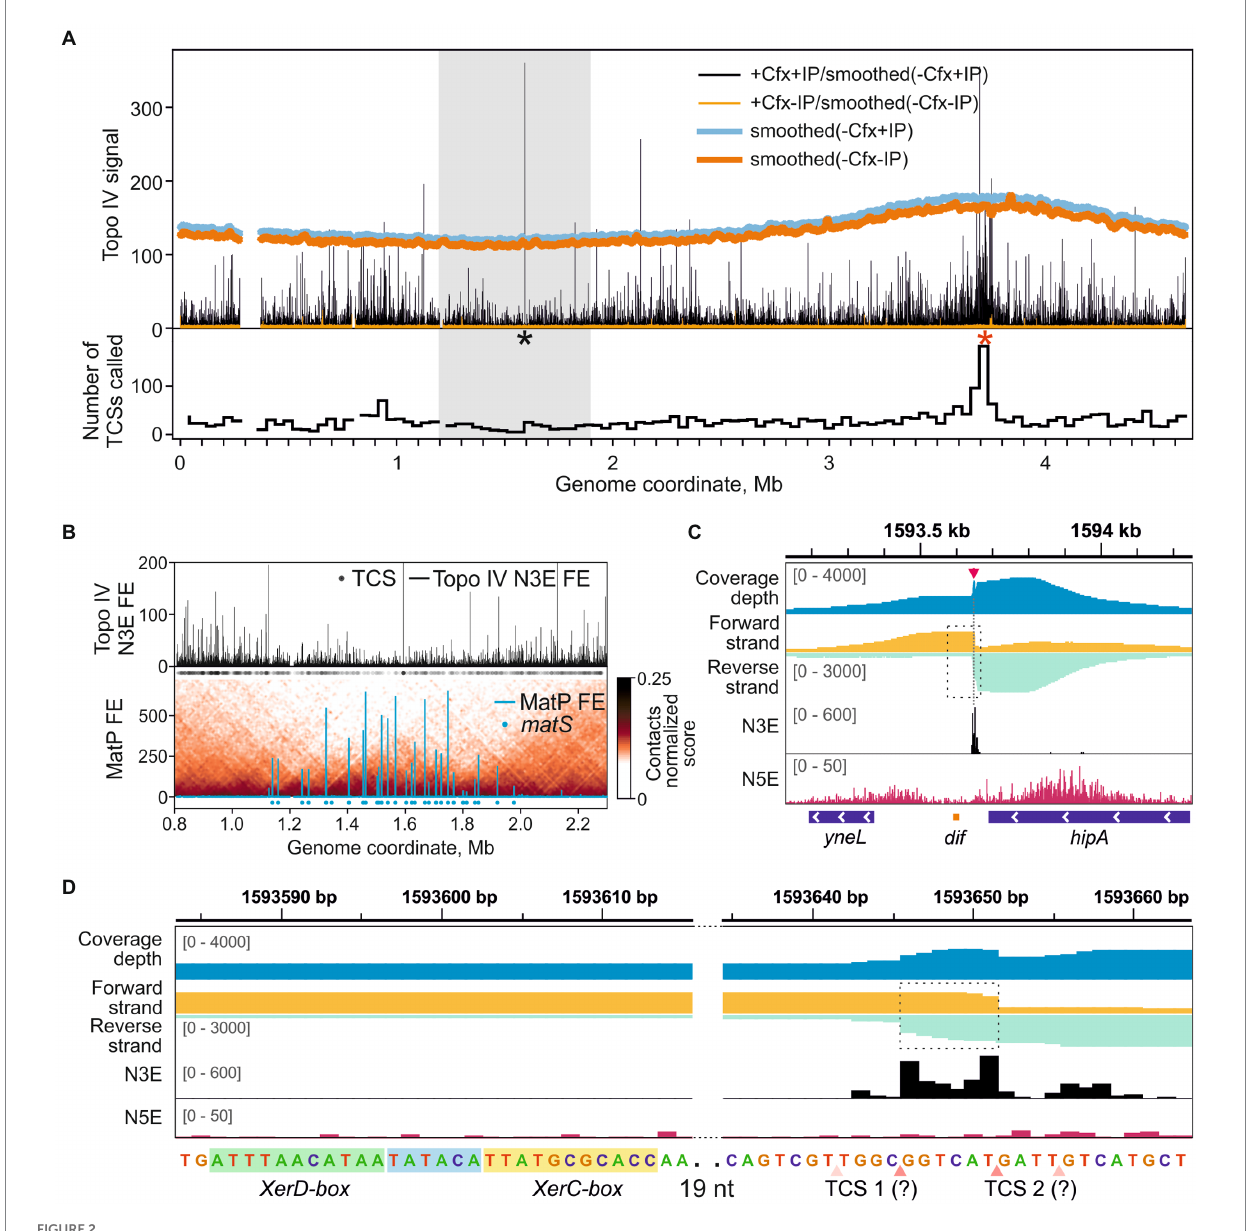
FIGURE 2 Topo IV cleavage activity at the dif -site. (A) Topo IV enrichment over the E. coli genome. Topo IV N3E fold enrichment (FE) for the +Cfx/+IP sample and the +Cfx/-IP control is shown in black and orange, respectively. Smoothed coverage depth tracks for -Cfx/+IP and -Cfx/-IP controls are shown in thick blue and dark orange curves, respectively. A black asterisk marks the position of the dif -site; red asterisk marks the position of oriC . A gray rectangle indicates the E. coli chromosome Ter MD. A plot representing the number of TCSs in 40 kb-wide genomic bins is shown below. (B) Topo IV N3E FE in the Ter macrodomain (upper plot). Black circles represent the positions of detected TCSs. MatP FE in Ter is shown below. Positions of matS -sites are shown with blue circles. Normalized contact map in Ter is shown in the underlying layer (resolution 10 kb). MatP data are taken from Nolivos et al. (2016), 3C contact data are taken from Lioy et al. (2018). (C) Topo IV enrichment and cleavage in the vicinity of the dif -site (orange rectangle below). N5E, N3E, and total coverage depth tracks are shown as in Figure 1A. Coverage depths for forward and reverse strands are shown in gold and turquoise, respectively. TCS is marked with a red arrow and a dashed line. A dashed rectangle indicates a region, containing the dif- site and the adjacent TCS, which is zoomed in (D) . The data are visualized in IGV (Thorvaldsdóttir et al., 2013). (D) Zoom-in of the dif -site region. Genomic sequence with marked XerD and XerC boxes is given below. Hypothetical asymmetric adjacent TCSs are shown with pink triangles below. Translucent triangles indicate the absent or depleted cleavage in the second DNA strand. Dashed rectangle marks the anomalously enriched